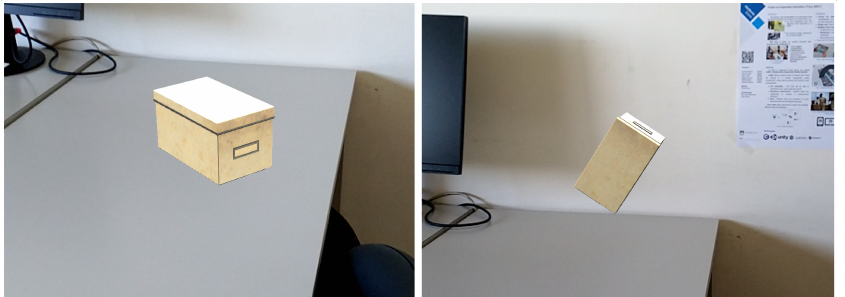
Figure 7. Placement of a virtual box onto a surface according to its normal vector. Depending on where the centre of the screen is aimed, the box base is placed parallel to the table ( left ) or to the wall ( right ) and in contact with the